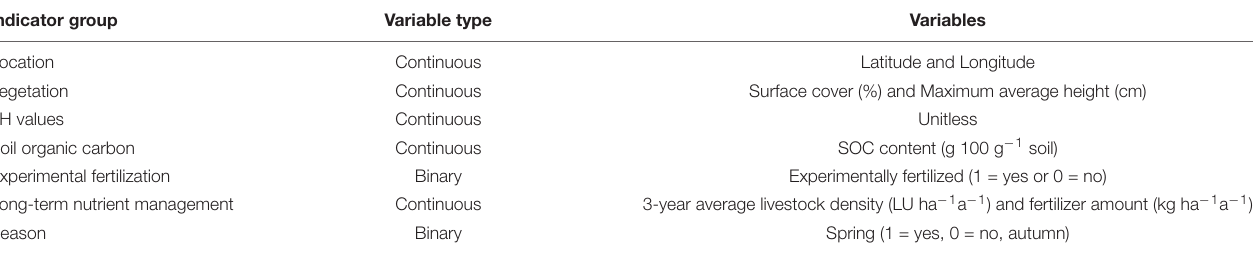
TABLE 2 | Indicator groups and the individual variables in each indicator group as used in all distance-based linear models (DistLM, McArdle and Anderson, 2001). Indicator